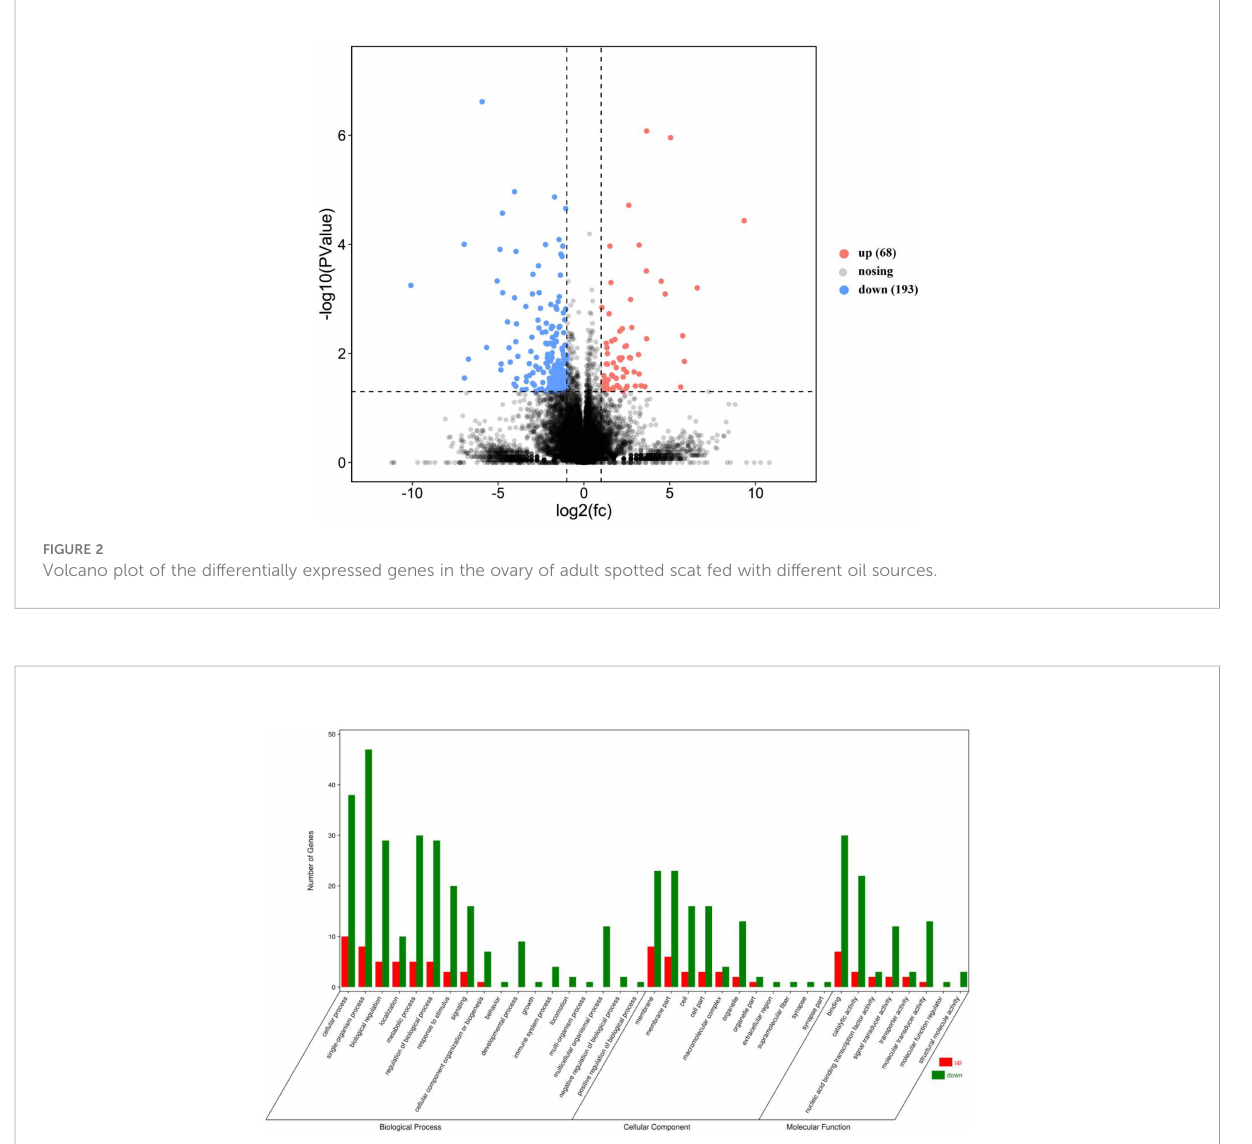
FIGURE 3 Gene ontology annotations of the differentially expressed unigenes in the ovary of adult spotted scat fed with different oil